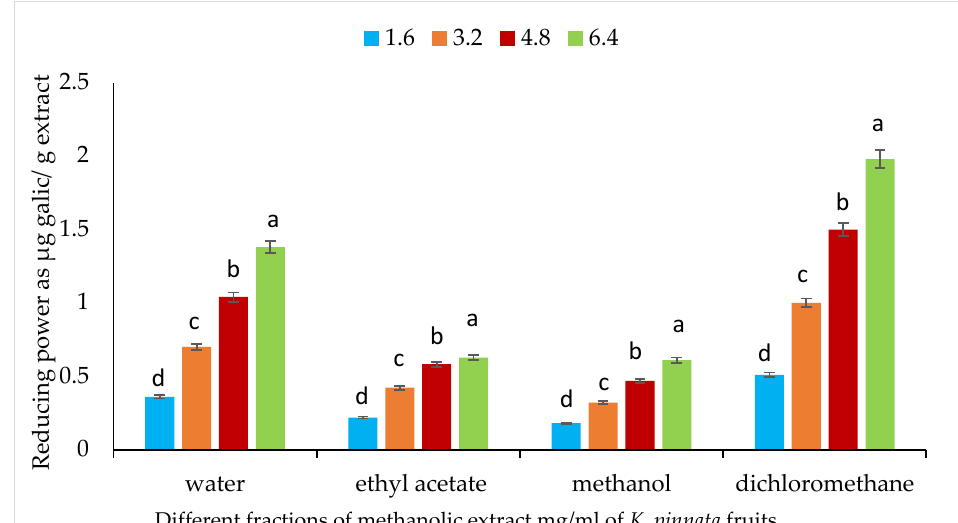
Figure 4. Reducing power of different fractions (water, ethyl acetate, methanol and dichloromethane) of mature (K m ) fruits of K. pinnata . The values are the means of three replicates with standard deviation ( ± SD). Duncan’s multiple tests ( p ≤ 0.05) found no statistically significant differences between the values in each bar with the same letter.